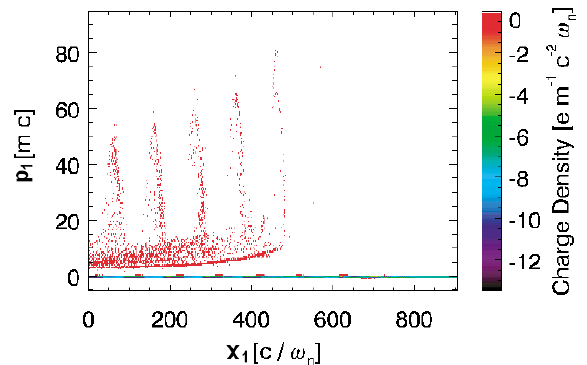
FIG. 5. (Video) The longitudinal phase space density plot at the time when the laser has reached the end of the constant density region of the second gas jet, which has the same density as the first gas jet. The parameters for both gas jets in this simulation are w i (cid:1) 1.5 mm, L gi (cid:1) 0.5 mm, and n pi (cid:1) 7.07 3 10 18 cm 2 3 . The distance between the gas jets is d (cid:1) 65 m m. See video 1 for the dynamic development of the phase space.